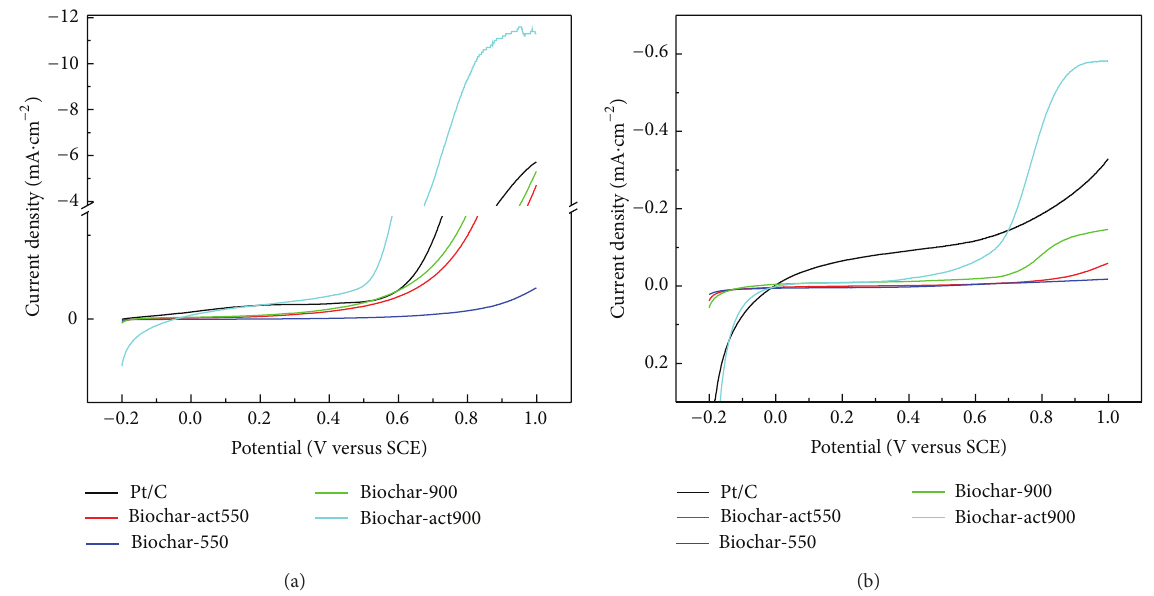
Figure 2: OER voltammetric curves in 0.1 mol/L KOH solution (a) and 0.25 mol/L K 2 SO 4 solution (b).